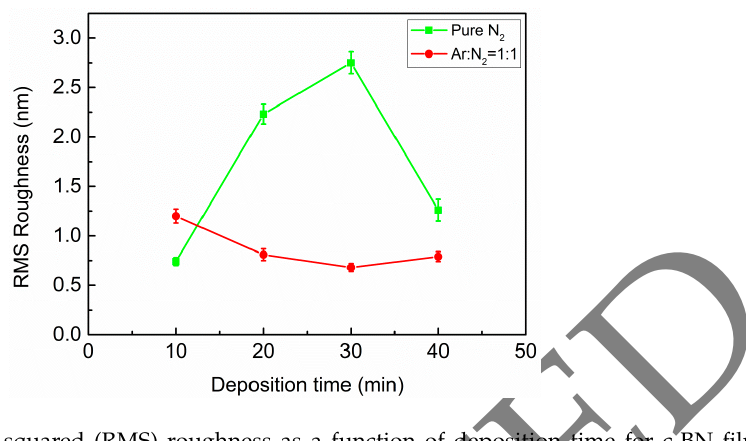
Figure 3. Root mean squared (RMS) roughness as a function of deposition time for c-BN films grown using pure N 2 plasma (square) and Ar/N 2 plasma (circle). The corresponding atomic force microscopy (AFM) images (4 μ m × 4 μ m) representing each data point are displayed in the Supplementary Materials.